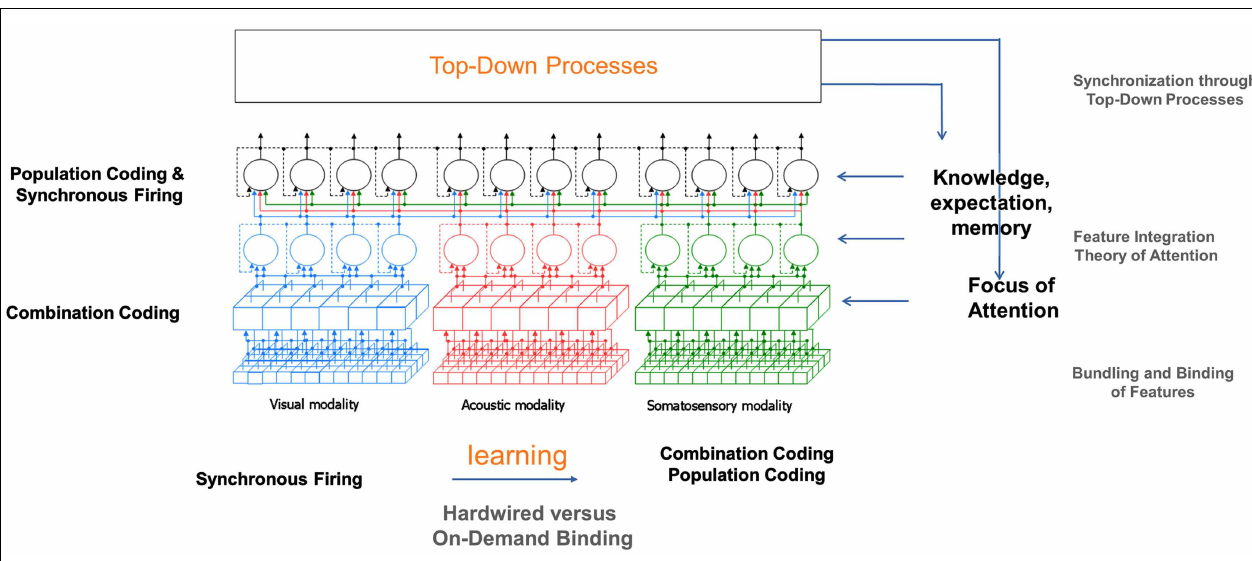
FIGURE 10 | Overview of binding mechanisms in perception at different hierarchical